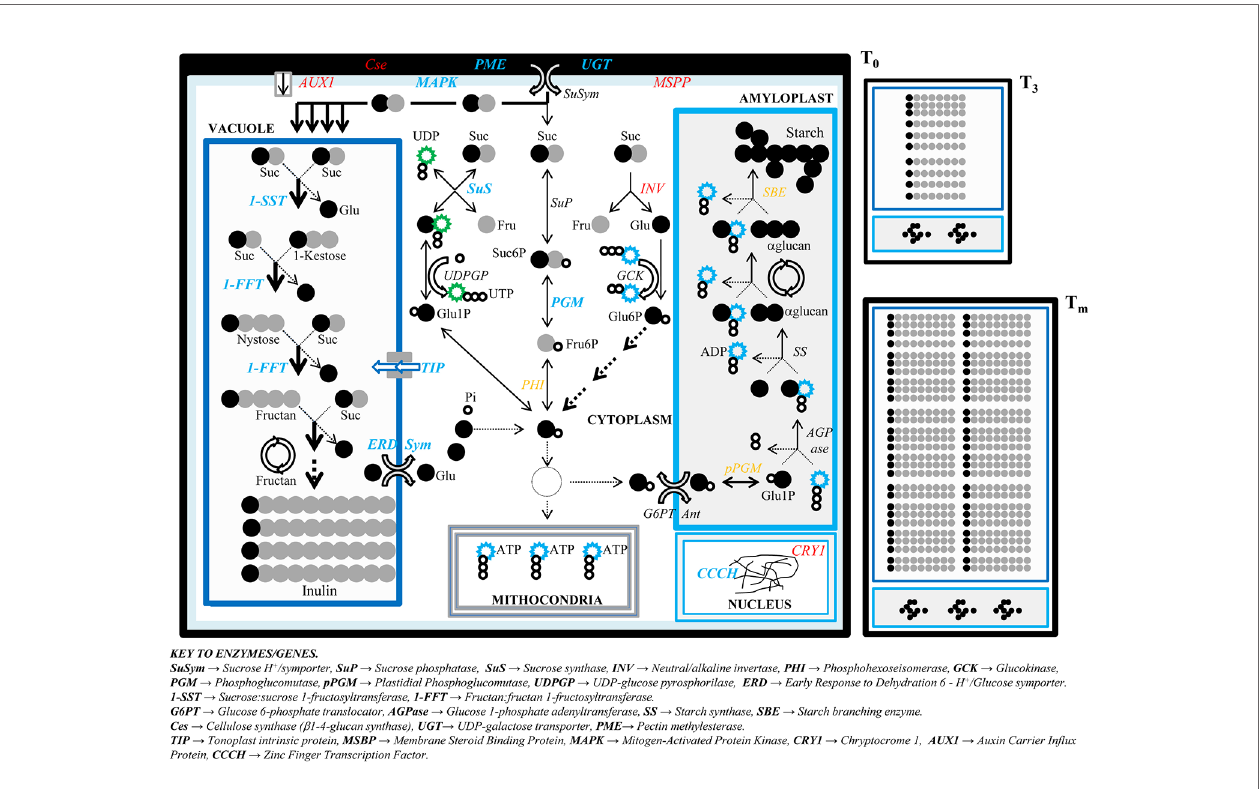
FIGURE 6 | Model of inulin accumulation and cell growth in developing tubers of Helianthus tuberosus . A scheme is proposed to display the metabolic pathways of sucrose breakdown in the cytoplasm, fructan polymerization in the vacuole, and starch biosynthesis in the amyloplast from when rhizome starts enlarging (T 0 ) until the stages of tuberous maximum growth rate (T 3 ) and fi nal tuber maturation (T m ). While cell at T 0 , regarded as the reference stage in tuber development process, is displayed in the foreground, cells at the two next stages, when inulin deposition takes place moderately (T 3 ) and massively (T m ), are depicted smaller near the T 0 cell. The main enzymes affecting the metabolism of carbohydrates as well as cell wall assembling and the overall cell growth are shown and placed in the cell compartments of their action. Emphasized arrows point to massive metabolic pathways. Enzymes whose genes are differentially expressed (DE) between T 0 and T m are reported in bold blue (if DE in both clones) or in red (if DE in one clone). The enzymes indicated in orange have genes not investigated in this